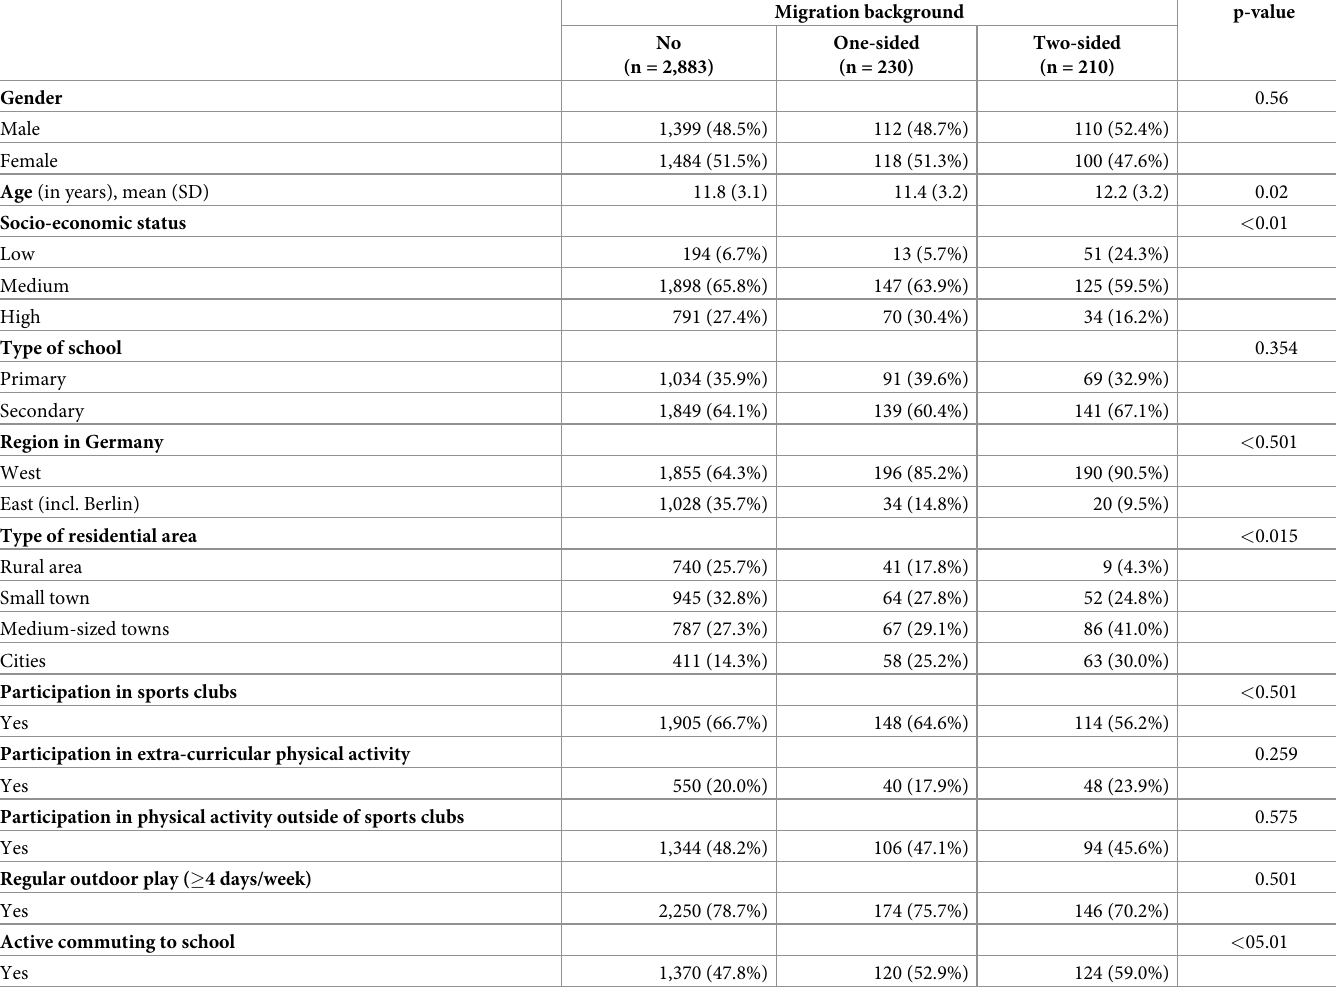
Table 1. Description of the study sample (data from the Motorik-Module Study [MoMo] Study; n =